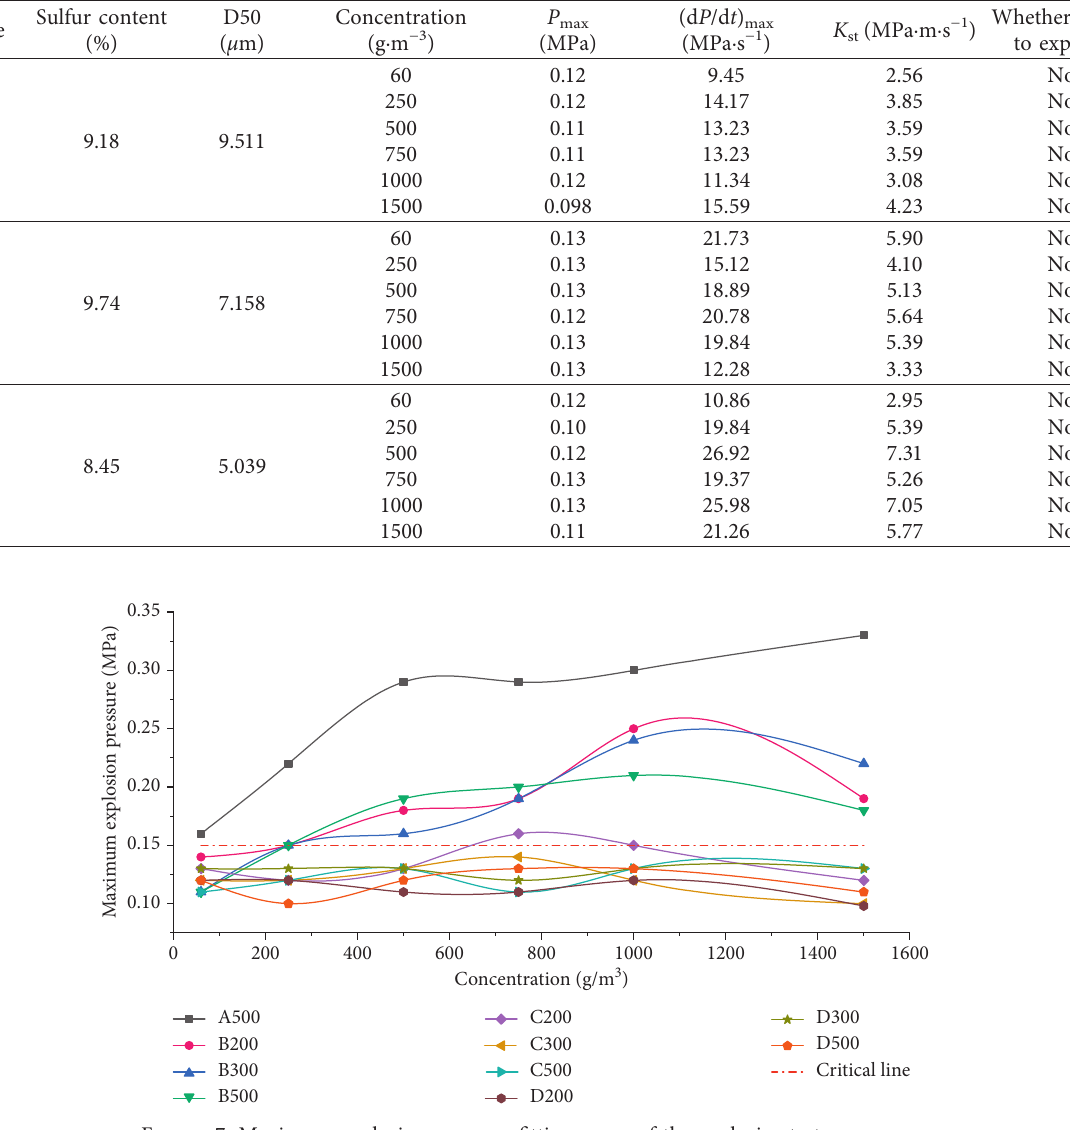
Figure 7: Maximum explosion pressure fitting curve of the explosive test